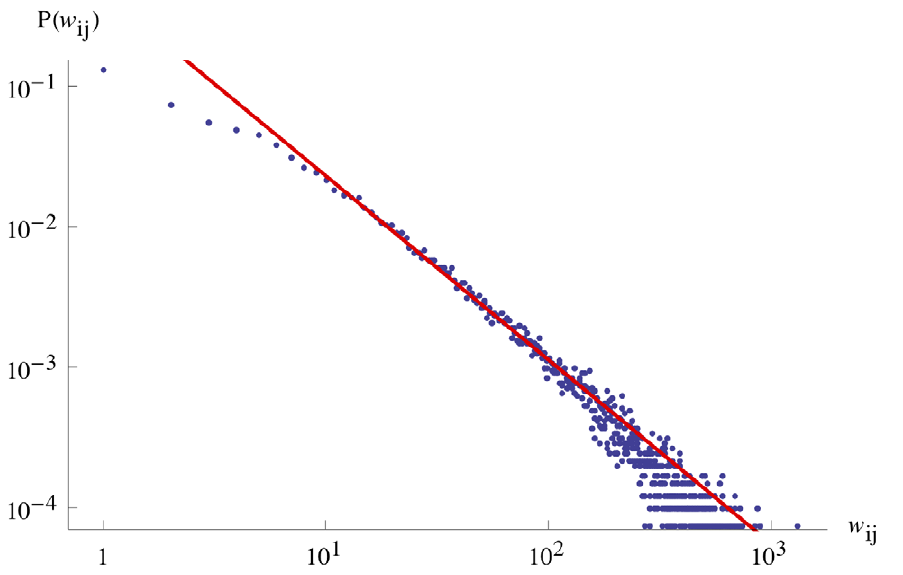
Figure 1. Flow distribution. Loglog plot of the histogram of the number of trips between two stations of the tube system. The line is a power law fit with exponent & 1 : 3 .